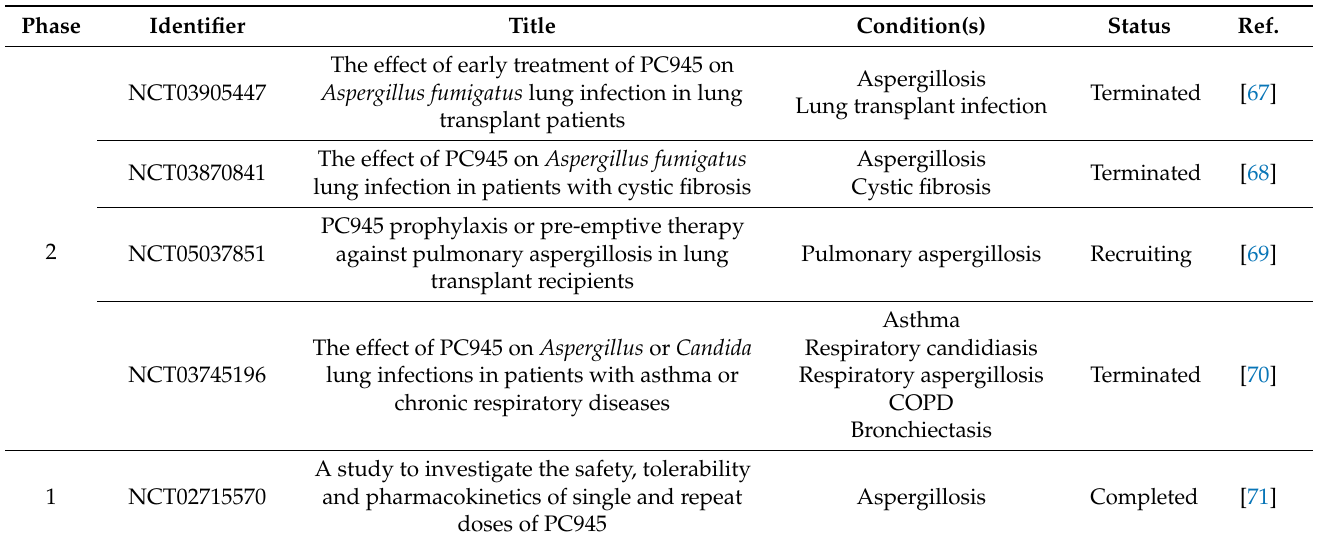
Table 5. Clinical trials of PC945 ( 16 ) (summarized).